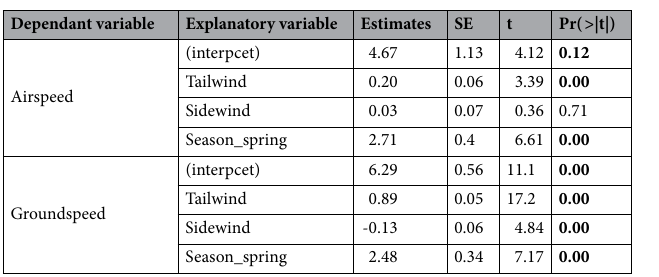
Table 7. Fixed effects on bird groundspeed and airspeed as estimated by our best LMMs. We consider coefficient estimates to be significant at P < 0.05 (bold).